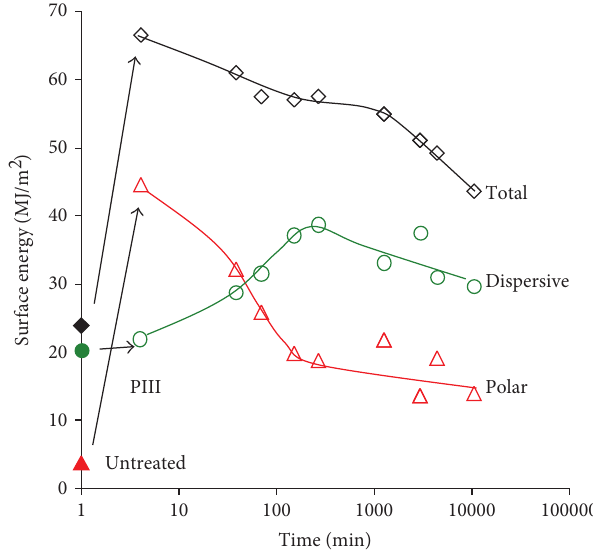
F 12: Total surface energy and its parts (polar and dispersic) of LDPE with time aer PIII treatment. Full signs correspond to untreated LDPE surface. Empty signs correspond to PIII-treated LDPE surface. Continuous lines correspond to (1) and